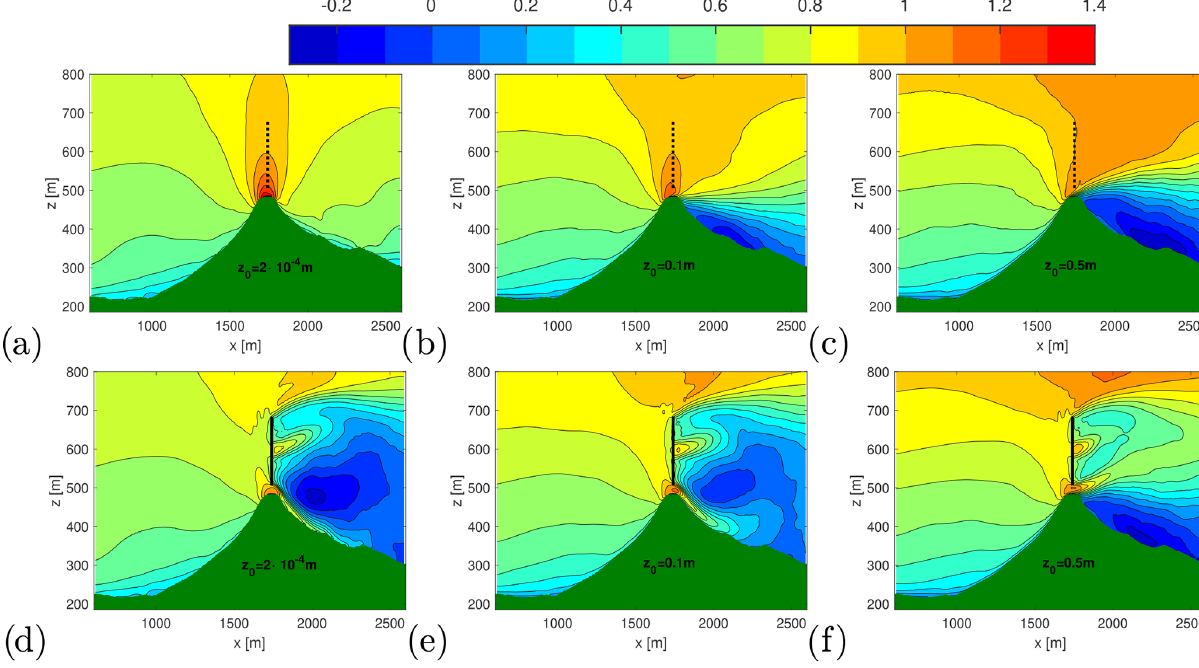
Figure 2. Contours of the mean streamwise velocity without (a–c) and with (d–f) the turbine included at different surface roughness levels. The velocities are scaled with the free-stream velocity at the hub position of the wind